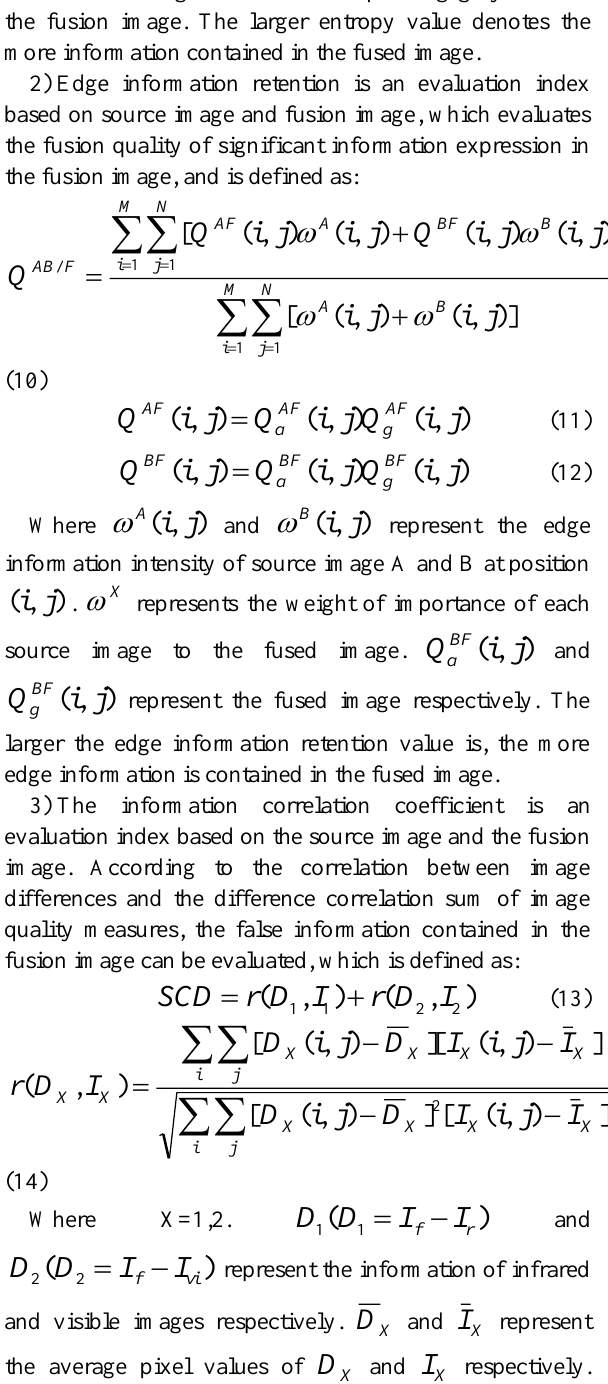
D and I represent X X D and I X X